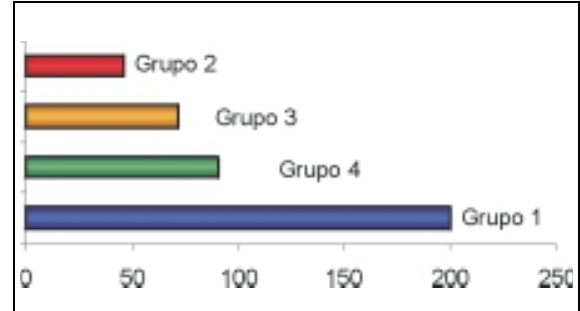
FIGURA 1 - Gráfico demonstrando que o tempo de sobrevivência nos respectivos grupos foi: 1= 200 dias; 2= 46 dias; 3= 71 dias; e 4= 90